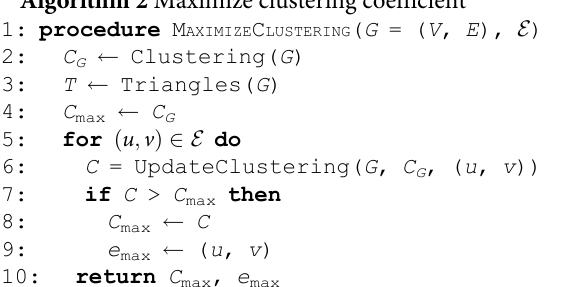
Algorithm 2 Maximize clustering coefficient